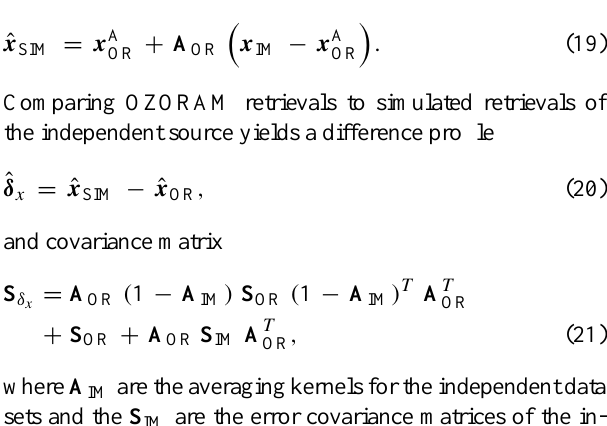
Fig. 7. Uncertainty in the profile due to errors in the instrumental parameters and spectroscopy. The plot covers random error due to noise on the spectra, σ η , and systematic error due to deviations in the temperature of the cold calibration load, σ T , in the atmospheric C temperature profile, σ T , and in spectroscopic parameters, namely pressure broadening, its temperature coefficient, and the line inten- q + σ 2 n + σ 2 σ 2 γ sity, σ γ , σ n and σ T , respectively. σ fp = I 0 AIR AIR AIR 0 AIR q + σ 2 + σ 2 + σ 2 σ 2 and σ TOT = η T C T fp